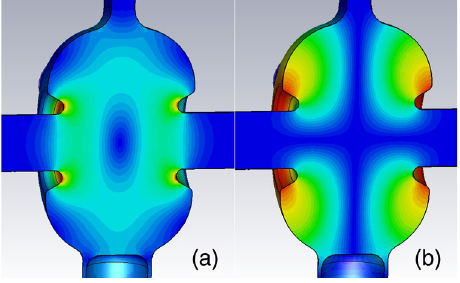
FIG. 5. Field pattern of the important 1.087 GHz HOM in the 704 MHz warm cavity: (a) E field in the cross section; (b) H field in the cross section.